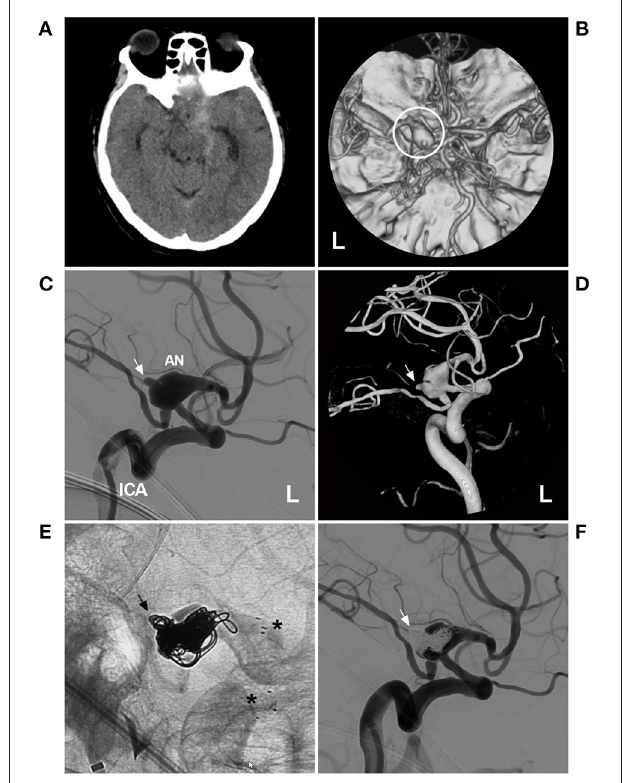
FIGURE 10 | Targeted coiling for a circumferential AN of the PcomA. (A) CT showed right subarachnoid hemorrhage around the brainstem and in the Sylvian fissure. (B) CTA showed a large AN of the left PcomA (circle). (C,D) DSA (C) and three-dimensional DSA (D) revealed the circumferential AN of the left PcomA segment, with a ruptured bleb on the top (arrow). (E) X-ray film showed that the AN had been embolized with stent assistance (asterisks) and that the ruptured bleb had been filled by coils (arrow). (F) DSA indicated that the ruptured bleb had been satisfactorily treated by targeted embolization (arrow). AN, aneurysm; CT, computed tomography; CTA, computed tomography angiography; DSA, digital subtraction angiography; L, left; PcomA, posterior communicating